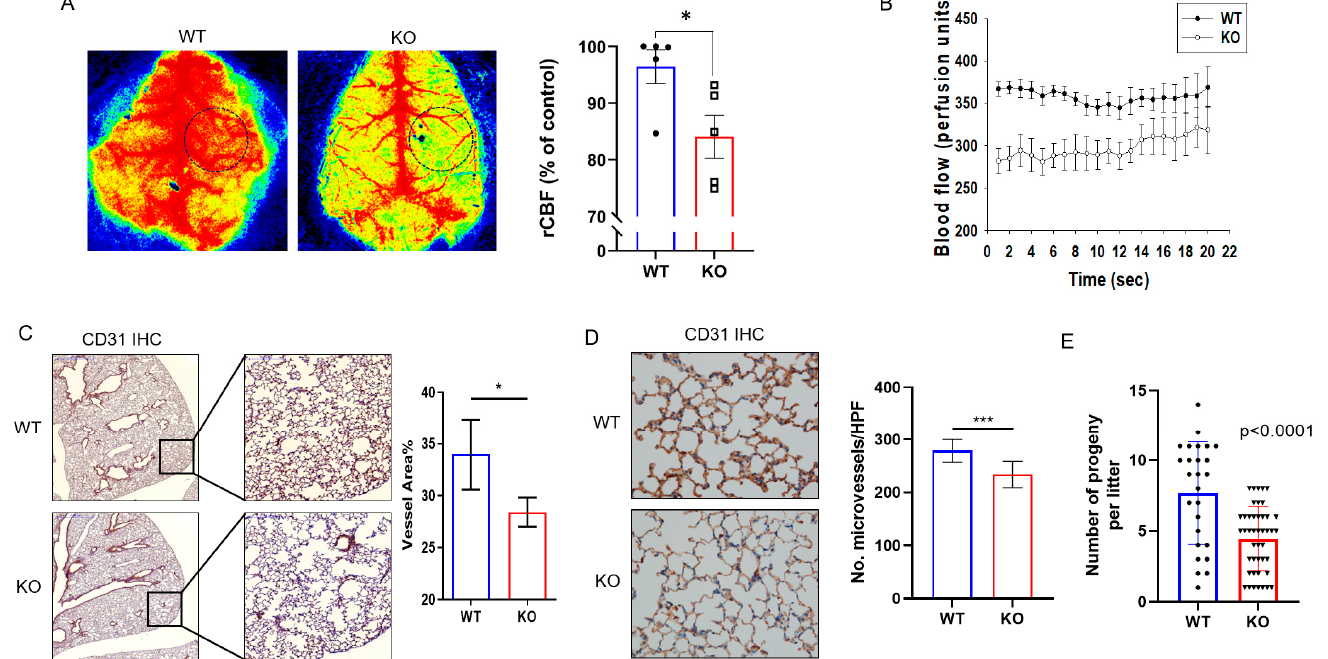
Figure 1. Effects of DRG2 deficiency on cerebral blood flow (CBF) and lung blood vessels density. ( A , B ) Effect of DRG2 deficiency on CBF. ( A ) Representative laser speckle images of cerebral blood perfusion in wild-type (WT) and DRG2 − / − (KO) mice. All images show areas of high and low blood perfusion as yellow–red and blue-black, respectively. CBF in the cerebral cortical area was calculated from the circular region-of-interest (ROI) (black dotted line) and quantified (n = 5 mice/group). * p < 0.05. ( B ) The time courses change in CBF at the circular ROI of the cerebral cortical area (n = 5 mice/group). ( C , D ) Effect of DRG2 deficiency on blood vessel density in mouse lung. ( C ) Repre- sentative microscopic images of CD31 immunohistochemistry in mouse lungs (original magnifica- tion, 10× and 40×, respectively) with quantification of vessel area fraction. The data are expressed as the mean ± SEM (n = 15 areas from 2 mice in each group). * p < 0.05. ( D ) Representative microscopic images from hot spot areas of mouse lung immunostained for CD31 (original magnification, 400×) with quantification of microvessel number per high-power field (HPF). The data are expressed as the mean ± SEM (n = 15 areas from 2 mice in each group). *** p < 0.001. ( E ) Quantification of the number of progeny per litter of wild-type and DRG2 − / − . The data are expressed as mean ± SD. (n = 26 for wild-type and 45 for DRG2 − / − ).